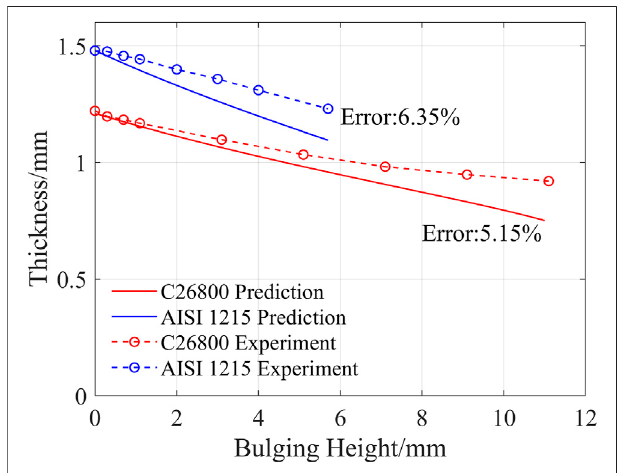
FIGURE 8 | BHL under changing. φ 0